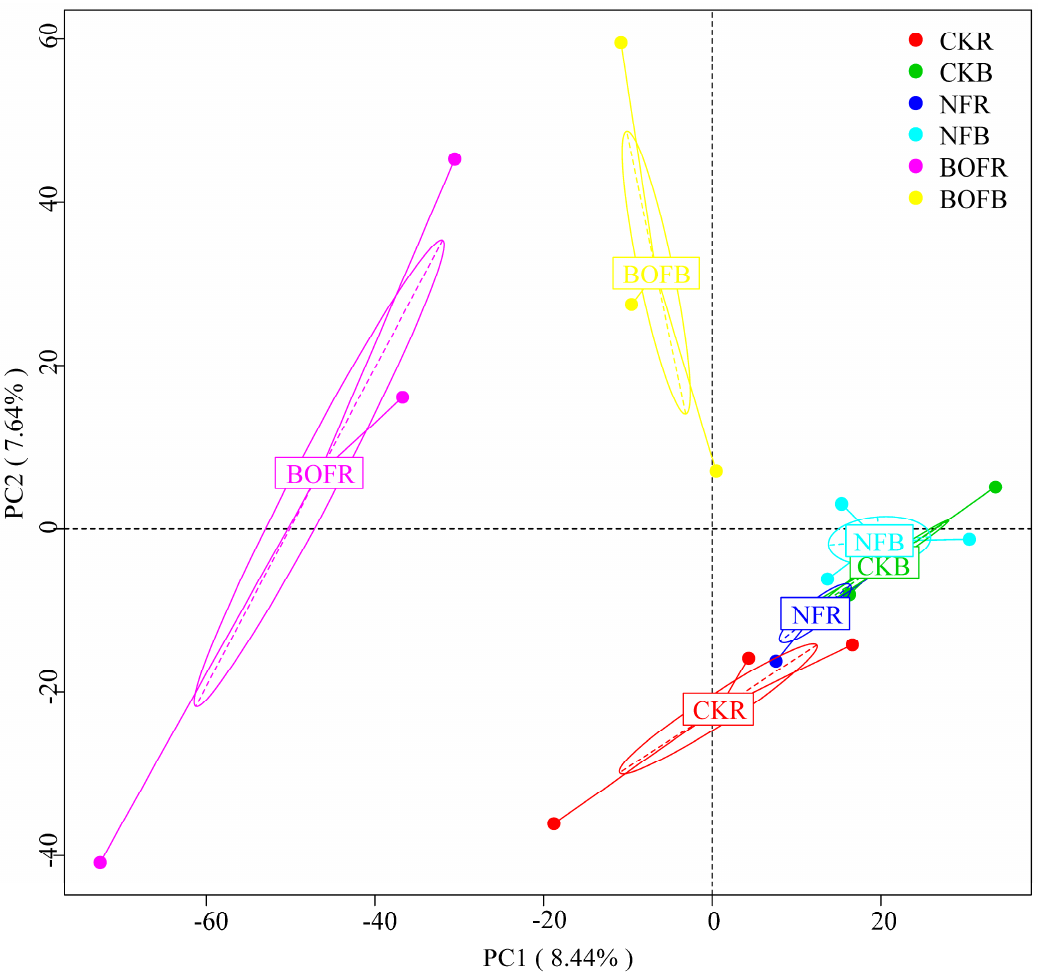
Figure 2. Principal components analysis of bacterial community structure in different fertilization treatments. CKR, rhizosphere of no fertilizer; CKB, bulk of no fertilizer; NFR, rhizosphere of nitrogen fertilizer; NFB, bulk of nitrogen fertilizer; BOFR, rhizosphere of bioorganic fertilizer; BOFB, bulk of bioorganic fertilizer.